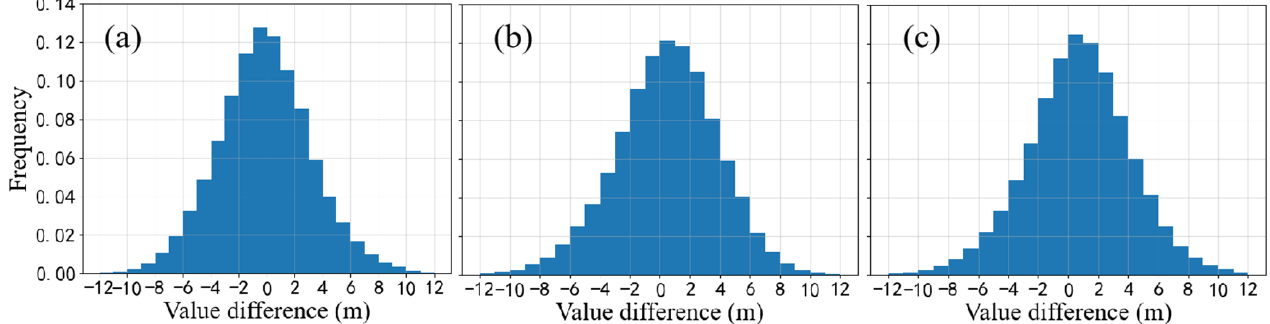
Figure 11. Histograms of the difference frequency distribution of predicted water depths for ( a ) Model I, ( b ) Model II, and ( c ) Model III. ( c ) Model